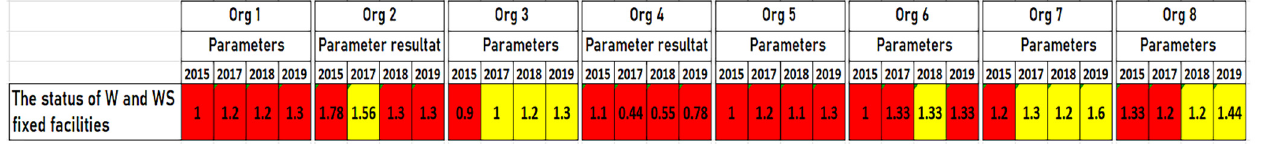
Figure 11. Results for parameter “Status of W and WS fixed facilities” for Orgs 1–8.